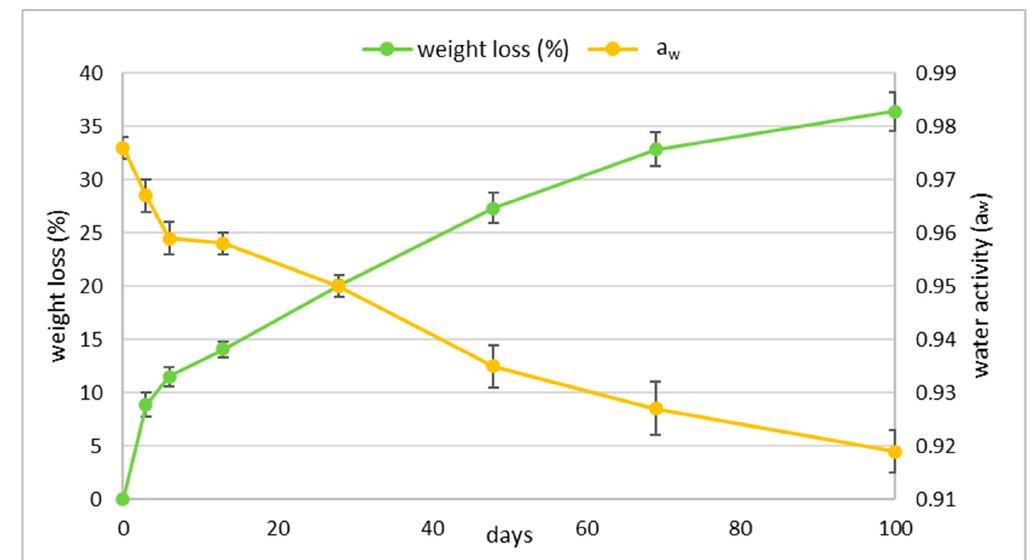
Figure 2. Evolution of weight loss and water activity (a w ) during the 100 days ripening period of Ventricina samples. Standard error bars are showed.